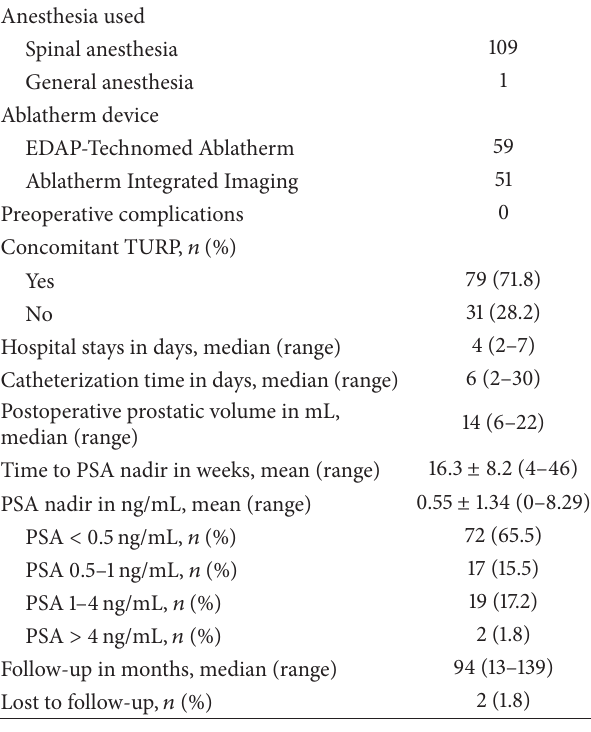
Table 1: Baseline and tumour characteristics of 110 patients with localized prostate cancer who were treated by a single session of high intensity focused ultrasound.